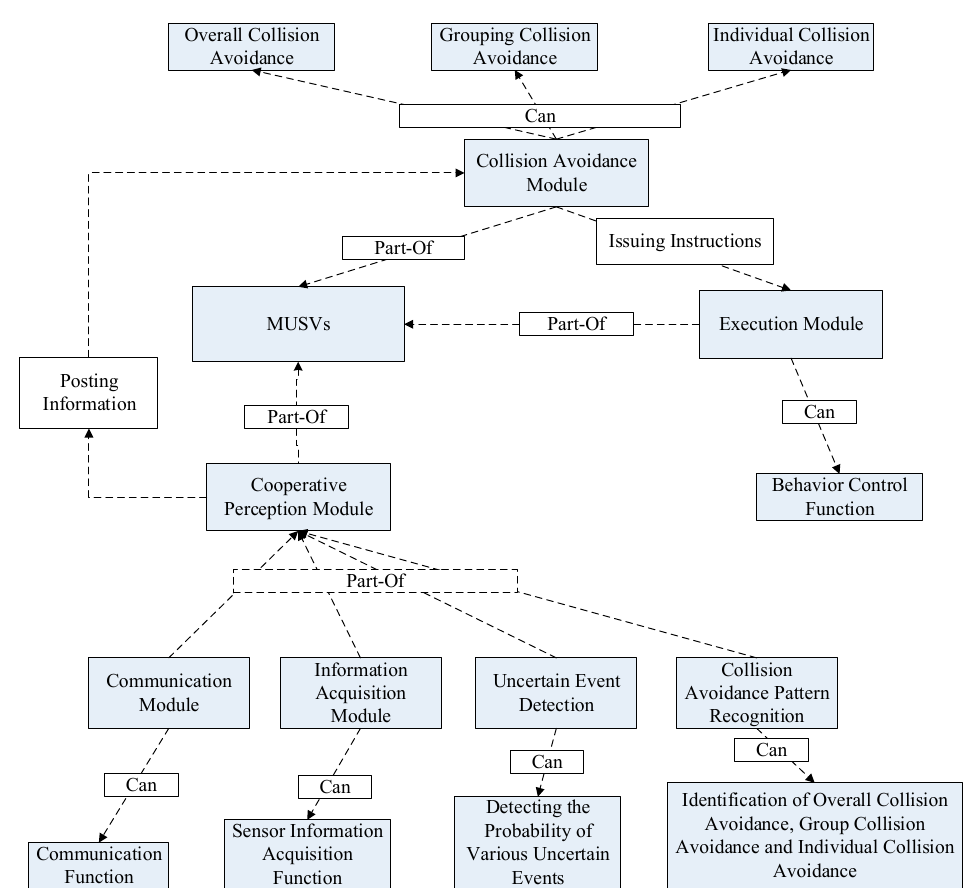
Figure 3. Ontology semantic knowledge framework of MUSVs formation safety navigation.